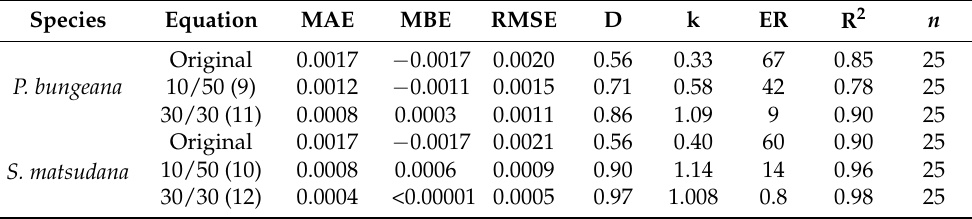
Table 2. Performance statistics for each sap flow density equation (equation number given in parentheses). MAE = mean absolute error; MBE = mean bias error; RMSE = root mean square error; D = Willmott’s index of agreement; k= the slope of the estimated value changing with the measured value; ER = error rate (%); R 2 = coefficient of determination; n = number of